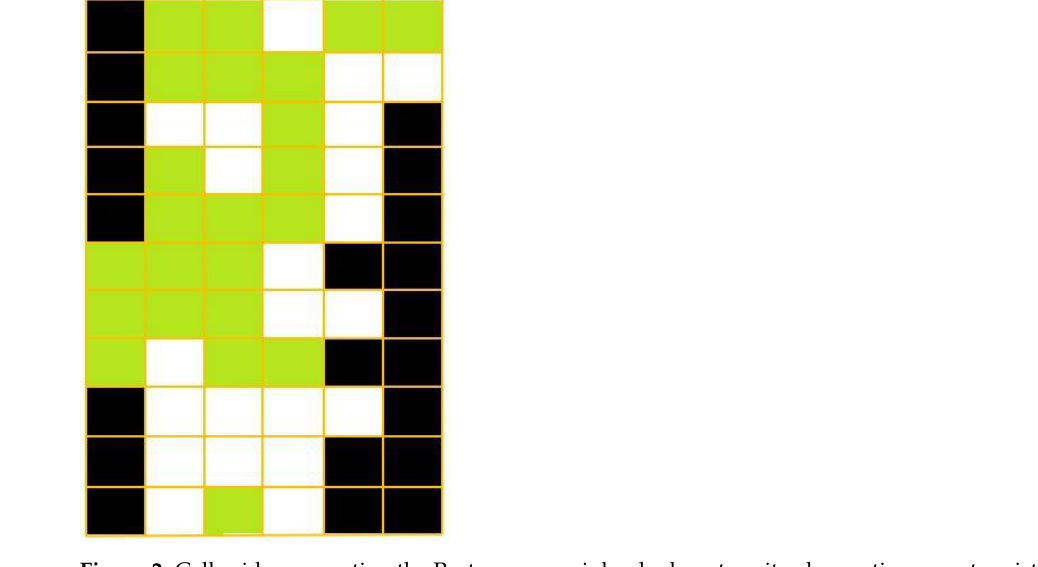
Figure 2. Cell grid representing the Portuguese mainland where termite observation reports existed before 1970. Each cell was defined according to termite presence (green) or absence (white) or to its being outside the Portuguese mainland territory (black).